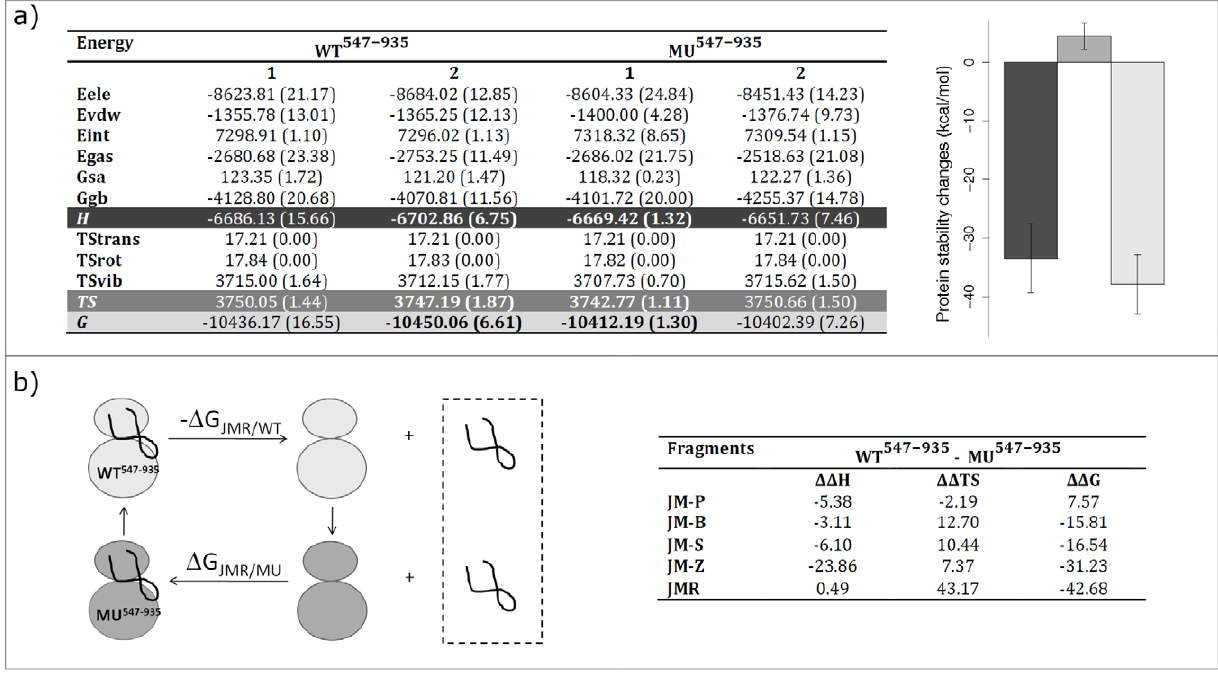
Figure 3. Protein stability and binding free energy changes between wild-type and D816V-mutated KIT in the inactive state. ( a ) Protein stability changes between wild-type and D816V-mutated KIT full-length CR: the table on the left gives the energetical contributions (in kcal/ mol) computed on simulations 1 and 2 of full-length CR for wild-type (WT 547-935 ) and mutant (MU 547-935 ); the barplot on the right gives enthalpic ( D H, in black), entropic ( D TS, in dark grey) and total energy ( D G, in light grey) changes computed from simulation 2 of WT 547-935 and simulation 1 of MU 547-935 (values in bold in the table). Statistical errors are given in parentheses in the table and represented as bars on the barplot. ( b ) Binding free energy changes of JMR and its fragments to KIT PTK between wild-type and mutant: the diagram on top represents a thermodynamic cycle picturing the dissociation of JMR from wild-type and mutated PTK; the table at the bottom gives the enthalpy ( DD H= DD G gas + DD G gb + DD G sa ), the entropy ( DD TS) and the total free energy ( DD G) differences (in kcal/mol), computed on the equilibrated conformations of WT 547-935 and MU 547-935 . The different energetical contributions are defined in the Materials and Methods section.